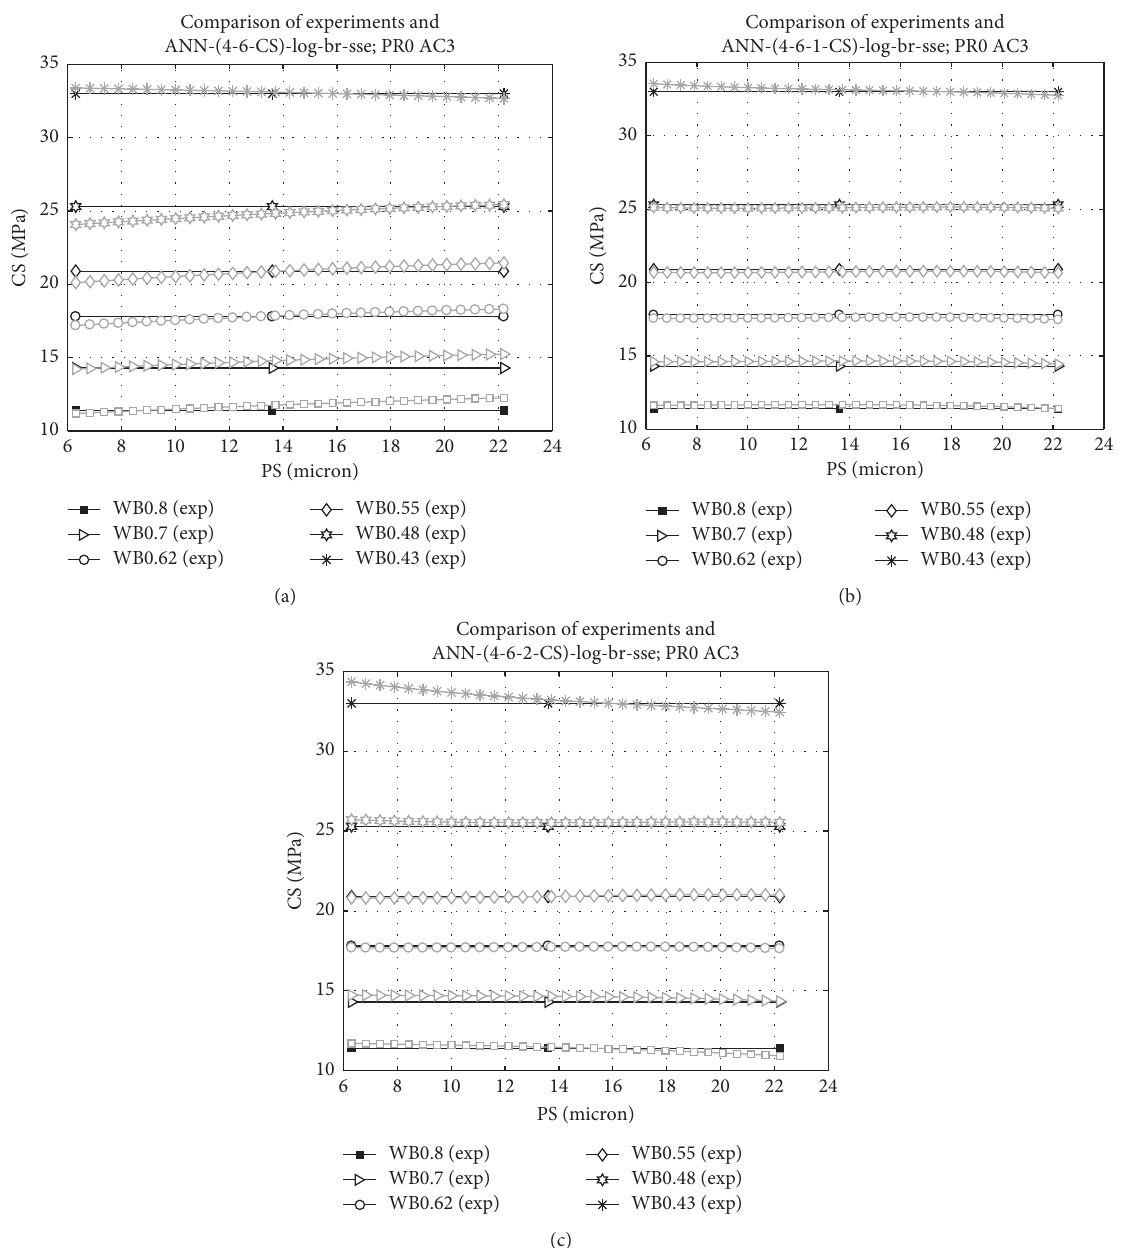
Figure 3: Comparison between the 2D plots of experimental results and predictive results of the ANN model architectures with two hidden layers. (a) Two hidden layers with 6 neurons in the first hidden layer and 0 neuron in the second hidden layer. (b) Two hidden layers with 6 neurons in the first hidden layer and 1 neuron in the second hidden layer. (c) Two hidden layers with 6 neurons in the first hidden layer and 2 neurons in the second hidden